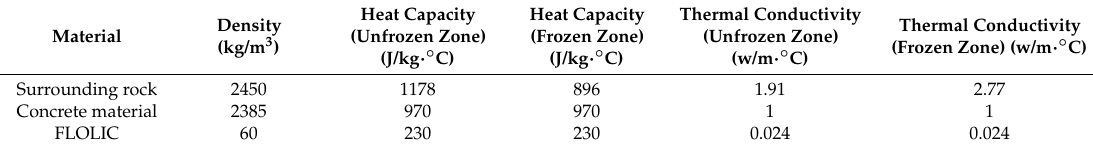
Table 1. Thermal physical